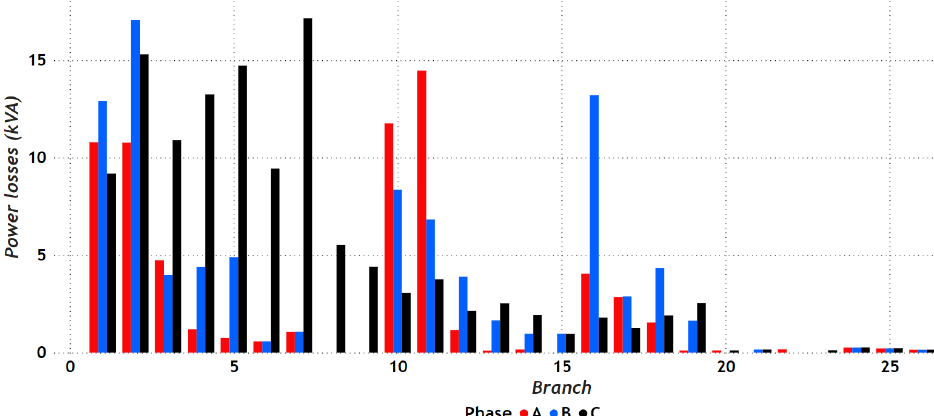
Figure 16. Power losses present in the branches of the three-phase 27-bus distribution system under an unbalanced load